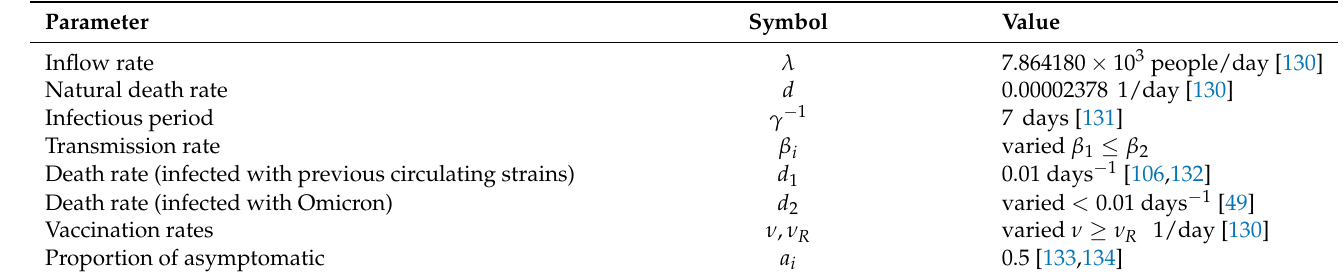
Table 1. Parameters for the Omicron wave mathematical model (2) with their respective meaning and numerical